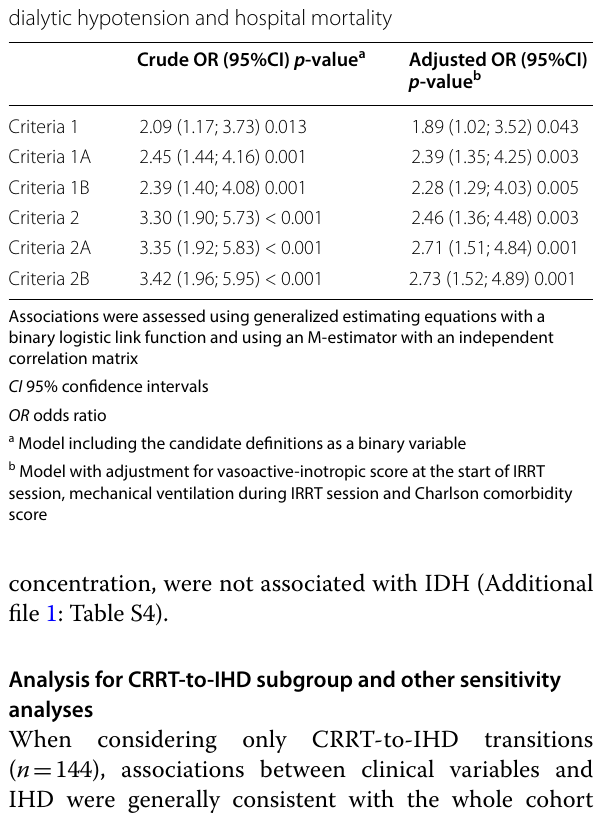
(Additional file 1: Table S6). The predictions models per- Table 3 Association between candidate definitions of intra‑